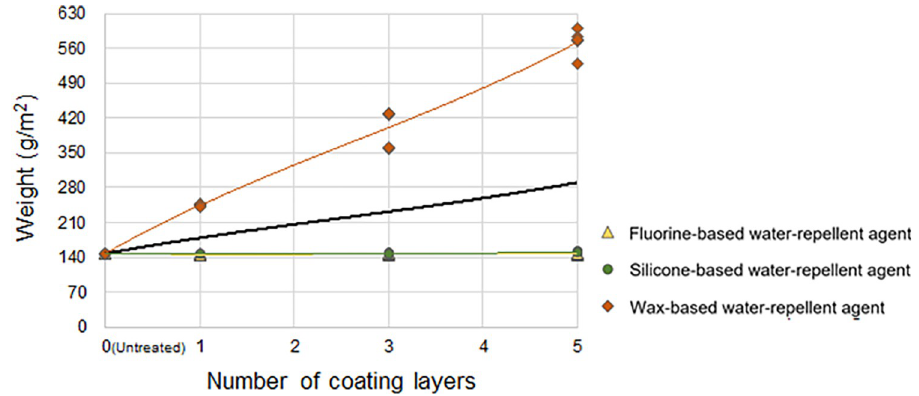
Fig 6. Weight of the cotton woven fabric according to the number of coating layers of the water-repellent agent. The black line represents the trendline (third-order polynomial).